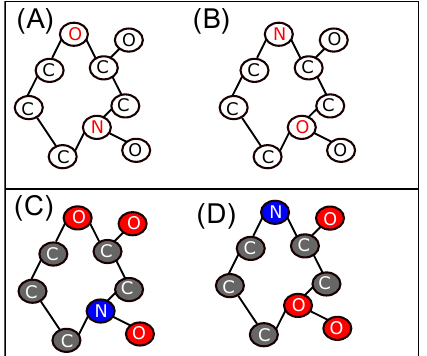
Figure 2. Example of isomorphic conformations represented by their 2D-MolGraphs. Top: confor- mations ( A ) (left) and ( B ) (right) are isomorphic by interchanging vertices N and O shown in red regardless of the chemical type of their corresponding atoms. Bottom: conformations ( C , D ) are not isomorphic anymore once the coloring process has been